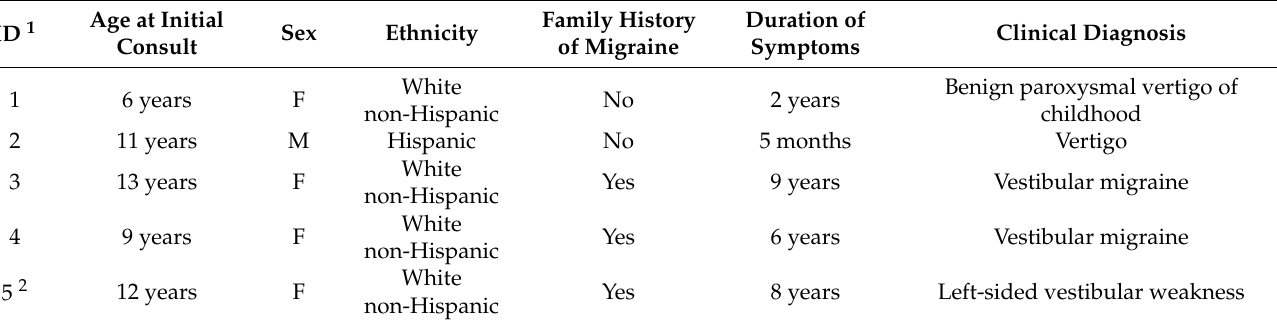
Table 1. Pediatric patients with peripheral vestibular